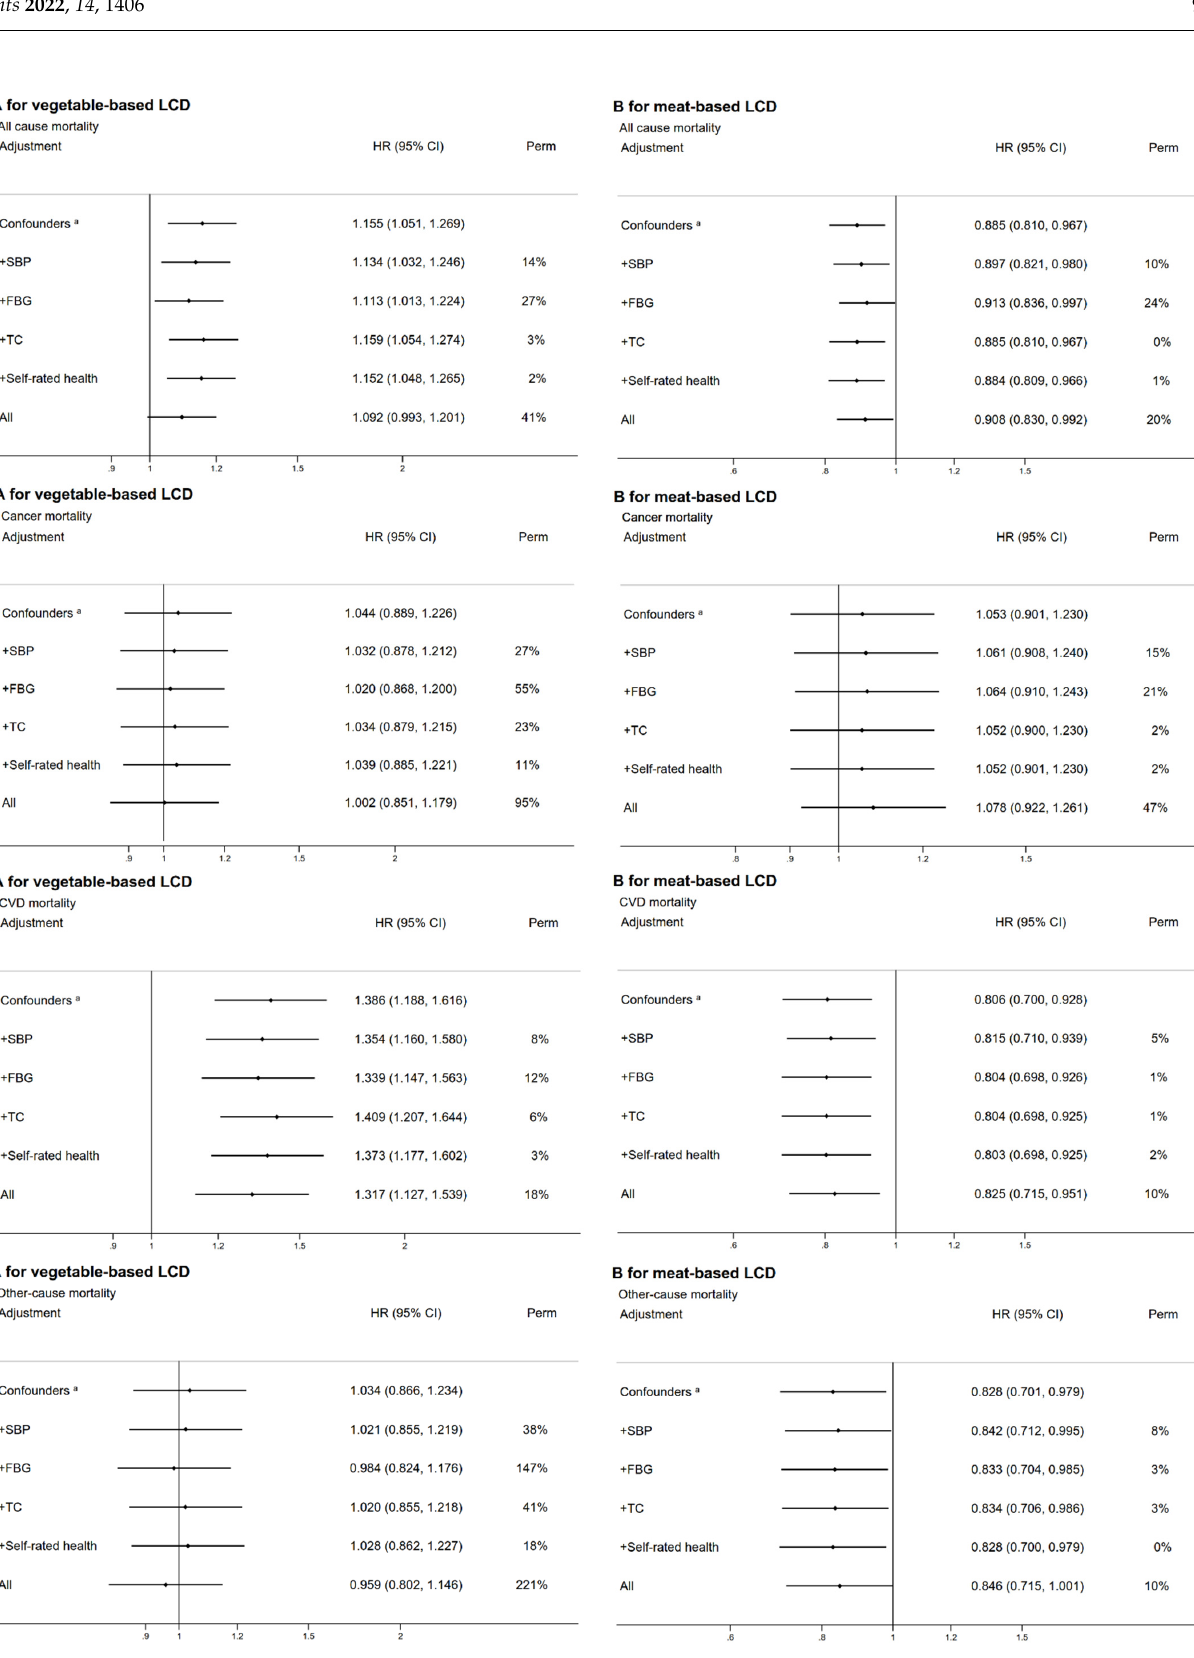
Figure 1. The associations between the LCD score (Q4 versus Q1) and all-cause mortality, and the proportions of the associations attributable to systolic blood pressure, fasting plasma-glucose, total cholesterol, and self-rated health in all-participants ( A : vegetable-based LCD score, B : meat-based LCD score).